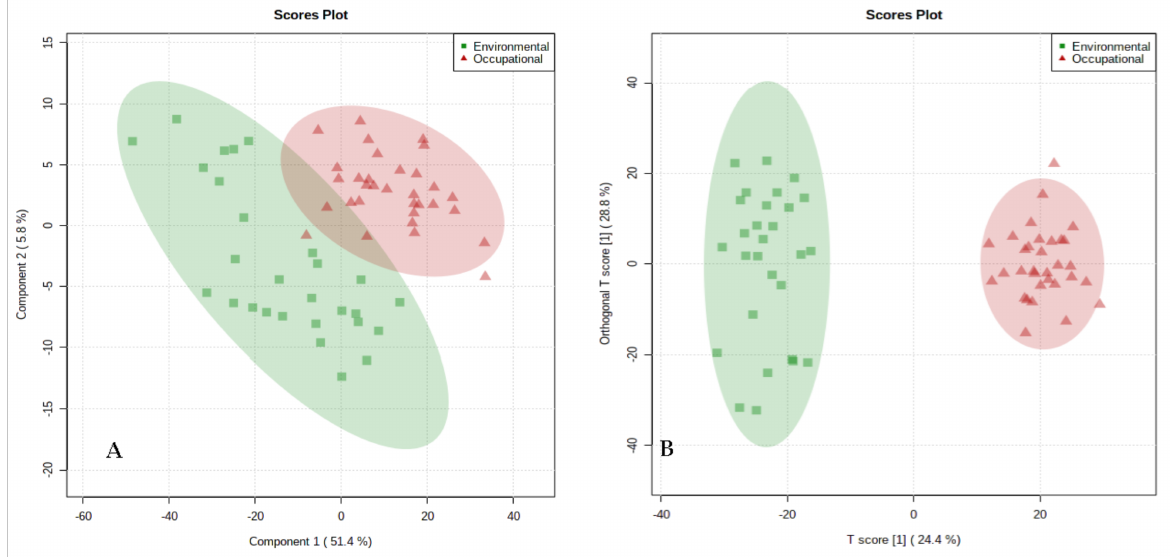
Figure 3. Partial least squares discriminant analysis (PLS − DA) and partial orthogonal discriminant analysis (OPLS − DA) of urine samples from workers exposed to environmental and occupational benzene, analyzed by UHPLC − ESI − Q − ToF − MS. Note: Red triangles represent samples from the occupational group and the green squares represent samples from the environmental group. ( A ): PLS − DA model, validation parameters: R 2 = 0.98, Q 2 = 0.87; ( B ): OPLS − DA